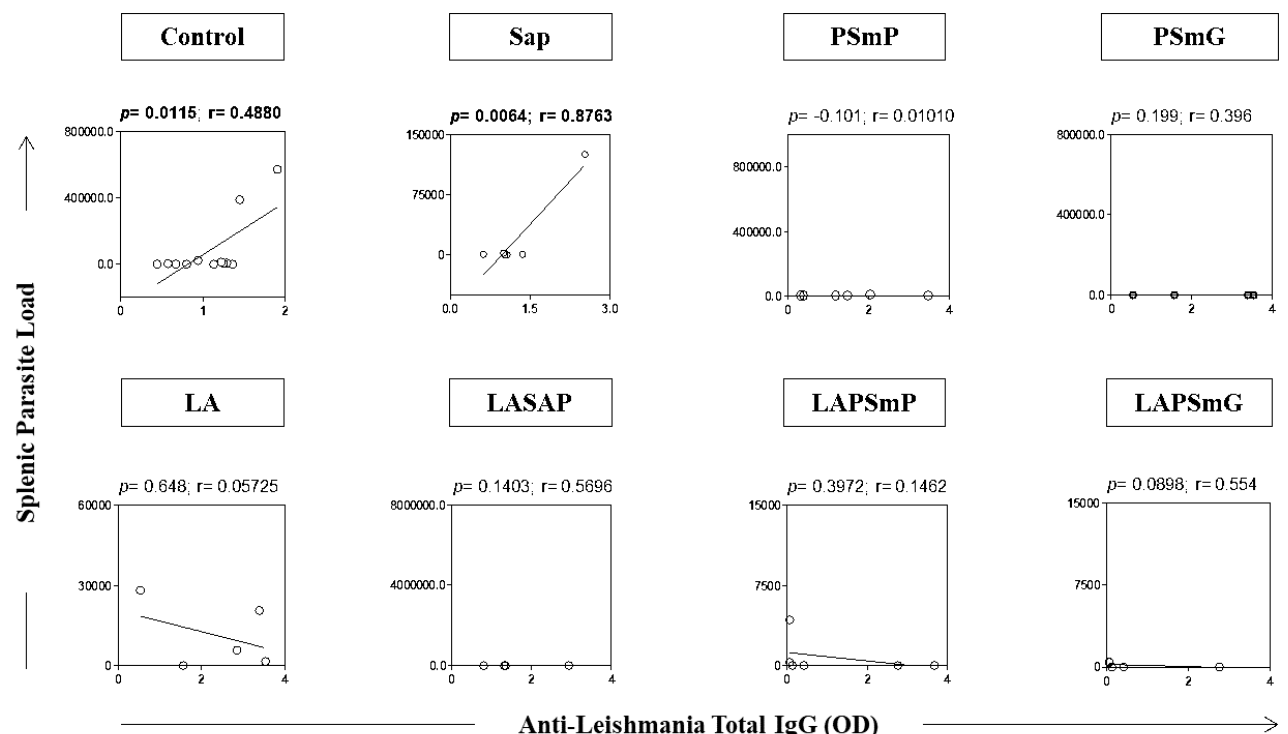
Figure 5. Correlation between splenic parasite load and total anti- Leishmania total IgG levels displayed as “ ”. The statistical difference was considered when p < 0.05. Legend: SAP: saponin; PSmP: small empty submicron particle; PSmG: large empty submicron particle; LA: L . amazonensis crude antigen; LASAP: L . amazonensis crude antigen associated with saponin; LAPSmP: small submicron particle associated with L . amazonensis ; LAPSmG: large submicron particle associated with L . amazonensis .